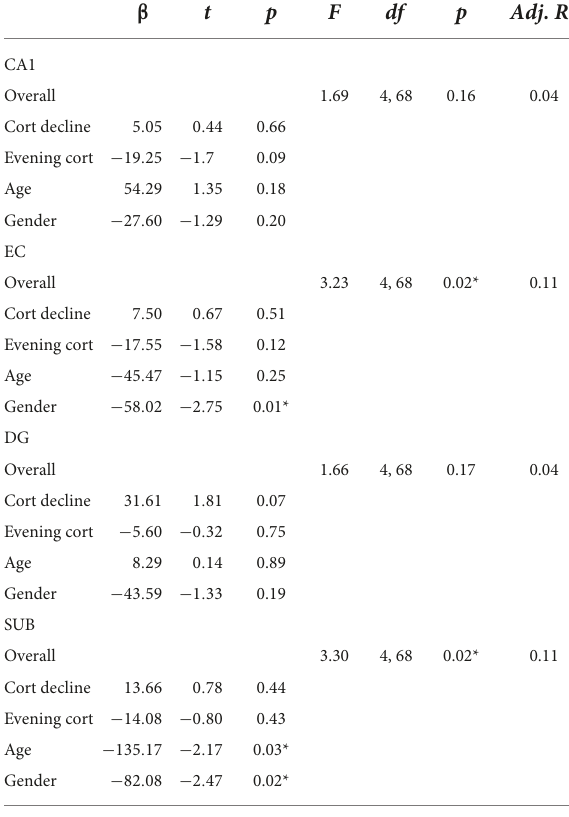
TABLE 5 Results of the multivariate regression analysis by hippocampal